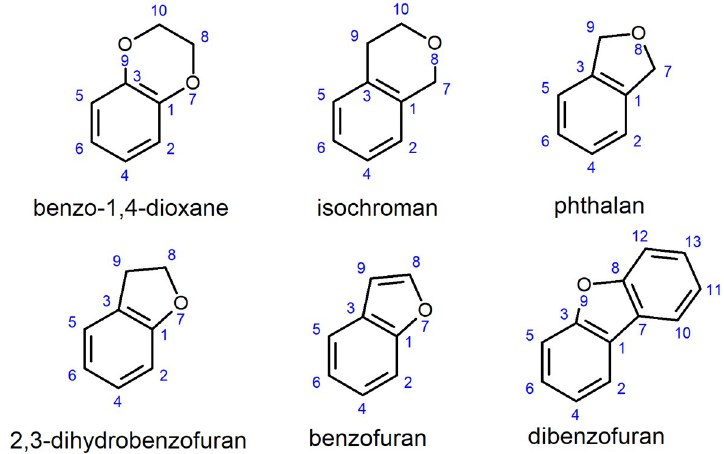
Figure 1. 2D chemical structure of the tested aromatic O-heterocycles.